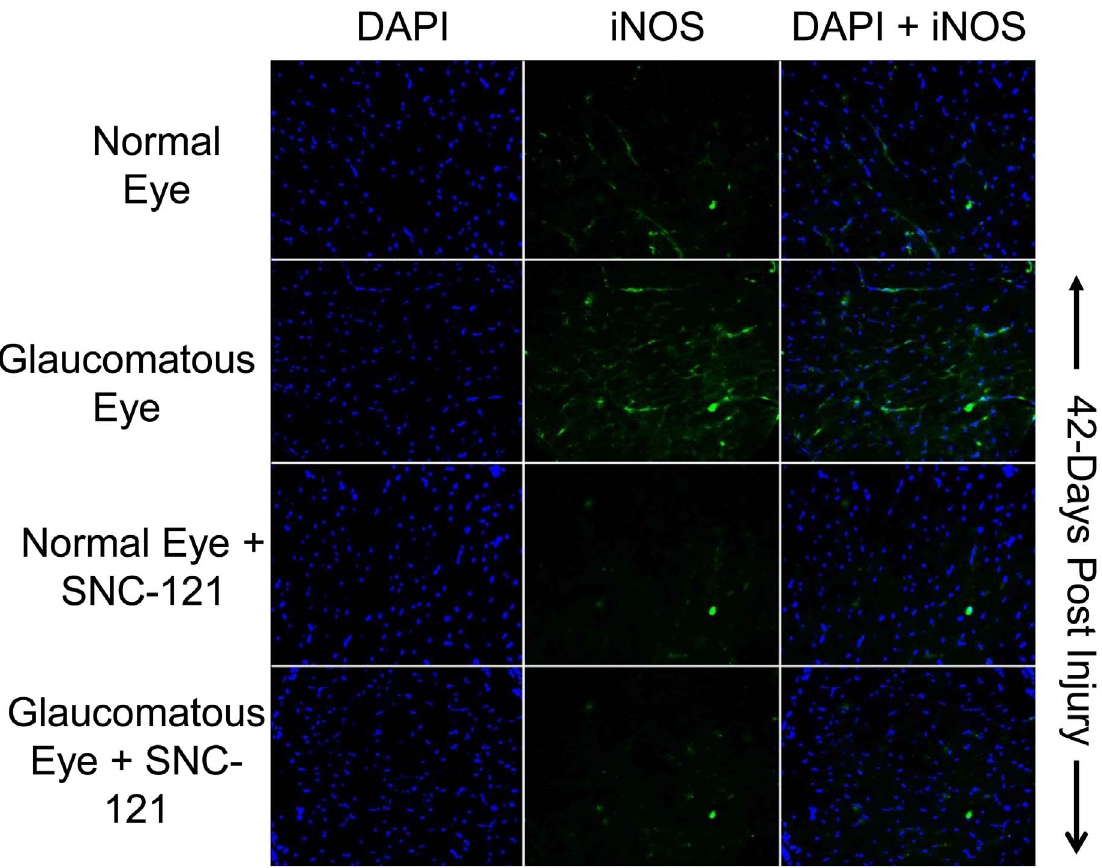
Figure 8. Changes in iNOS expression in glaucomatous optic nerve at 42 days, post injury. The optic nerve (non-myelinated; 2 mm post globe) of Brown Norway rats was removed 42-days post glaucomatous injury. Contralateral optic nerve was used as the normal control. Cryosections were immunostained by anti-iNOS antibodies as indicated horizontally. Ocular treatments are indicated vertically. Data shown in this Figure are a representation of at least four independent experiments. A total of 10 animals were used in this experiment. Comparable staining for iNOS was seen in at least 4 animals in each treatment group.